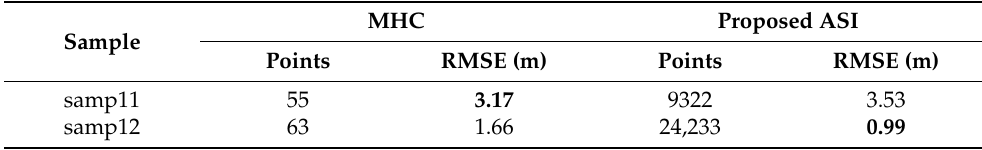
Table 8. Comparison between the RMSE and number of seeds obtained for each sample by Chen’s MHC method and the proposed ASI method. (The best RMSE results across all the methods at each sample are highlighted in